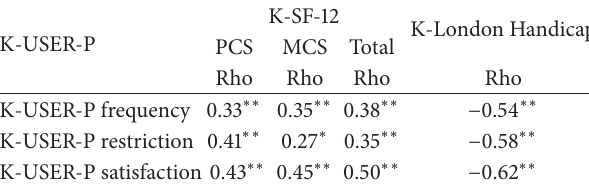
Table 4: Construct validity for USER-P ( 𝑁 = 67